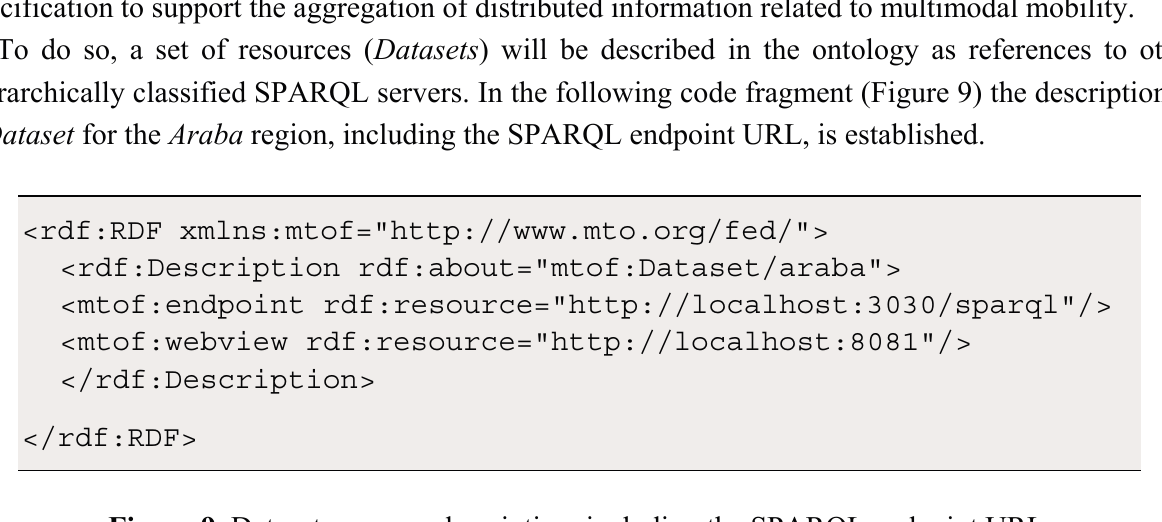
Figure 9. Dataset resource description, including the SPARQL endpoint